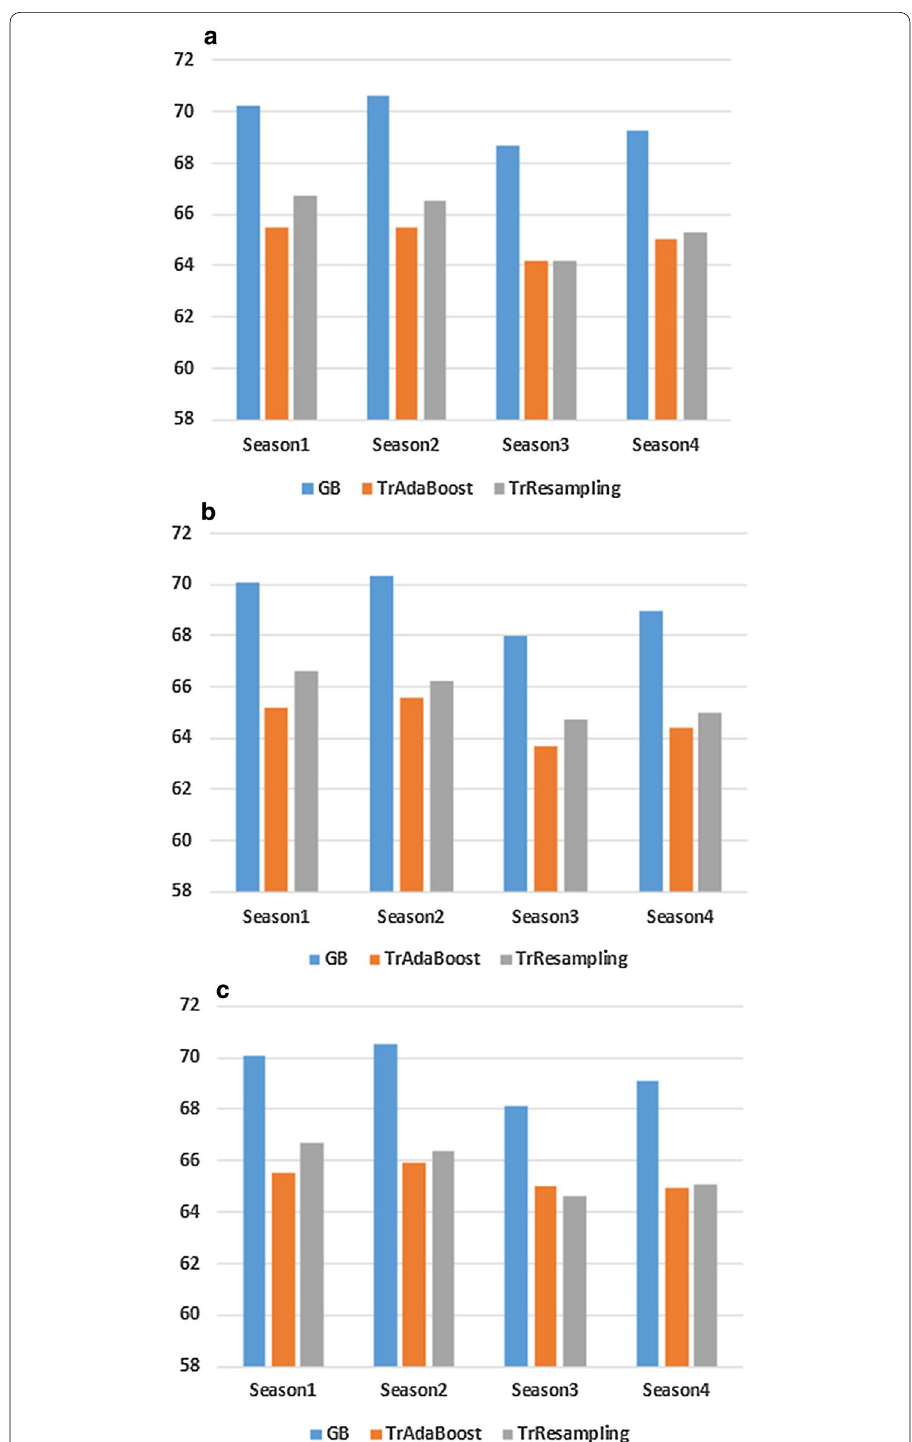
Fig. 8 Comparison of AUC scores. a Model 4 seasonal subset. b Model 5 seasonal subset. c Model 6 seasonal